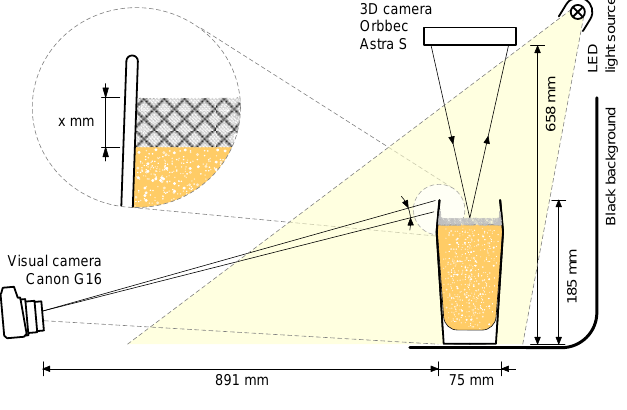
Figure 1. Experimental setup.